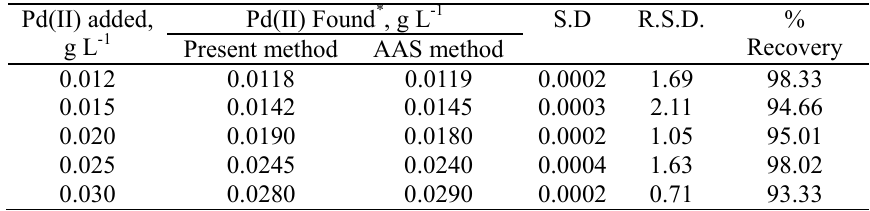
Table 3. Pd(II) concentration in the synthetic water